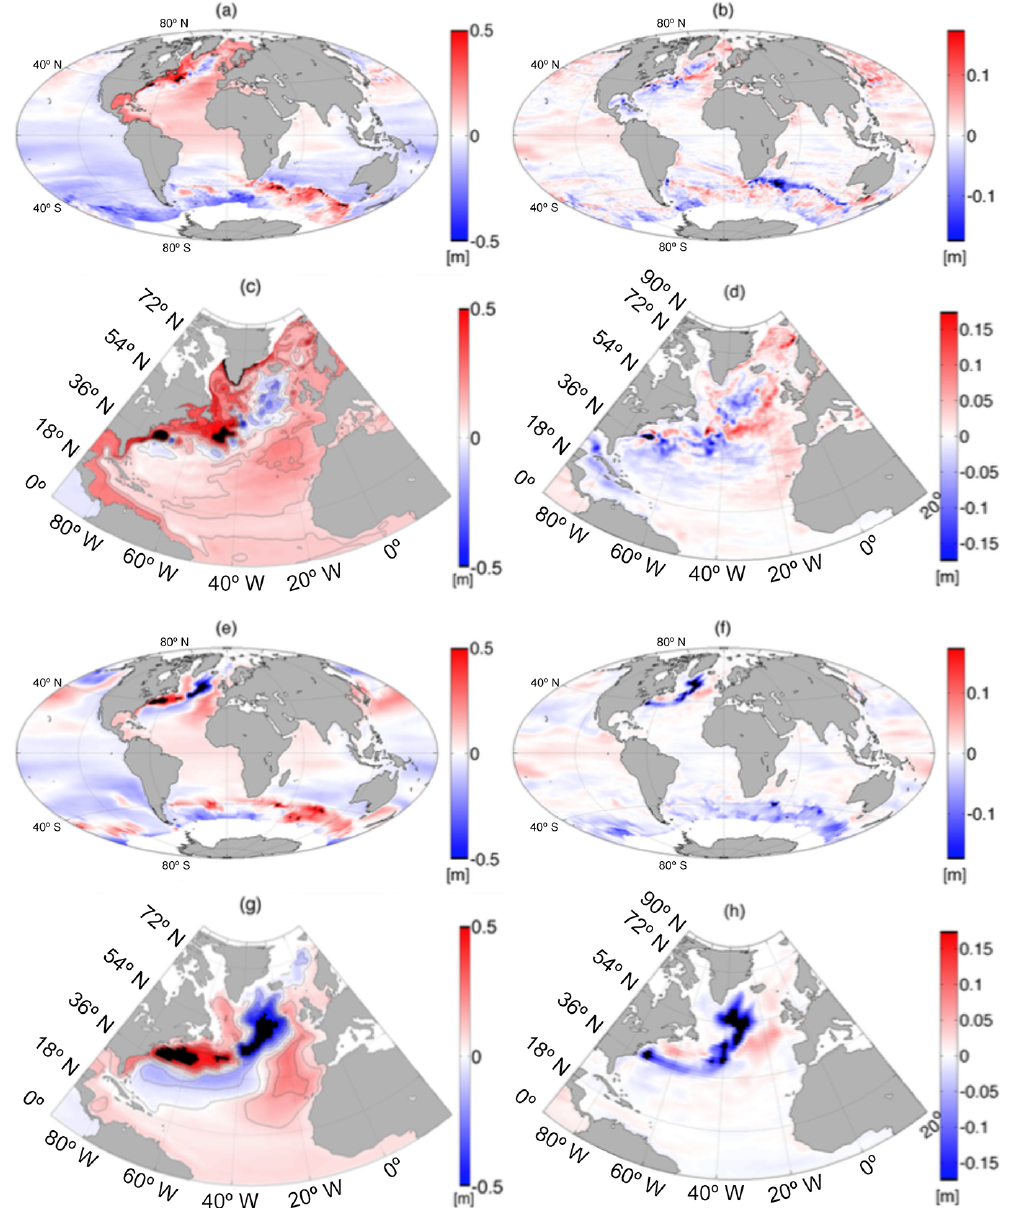
Figure 2. Change in the (a) mean and (b) standard deviation of modeled DSL in meters between the periods 2081–2100 and 2001–2020 for the R 021 simulation. The panels (c) and (d) are magnifications of (a) and (b) for the North Atlantic region. (e–h) Same as (a–d) but for the R low 021